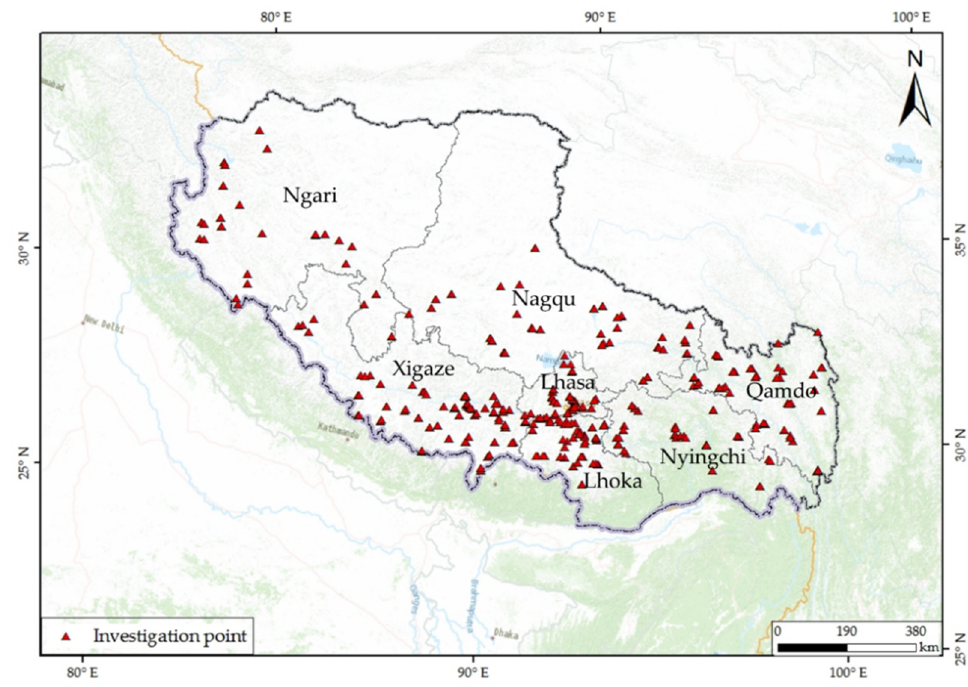
Figure 1. Location of residents who participated in the investigation in Tibet, China.